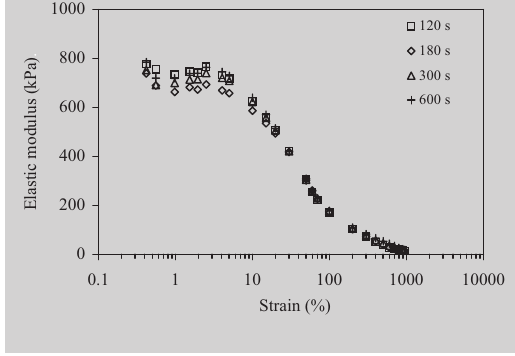
Figure 1 (left): Elastic modulus, G’, deter- mined from time sweep test of cured and uncured blends with 120 and 600 s mixing times. Figure 2: Elastic modulus, G’, as a function of % deformation strain at the test frequency of 3.14 rad/s (Payne effect) in filled vulcanised CPE/NR blends with various mixing